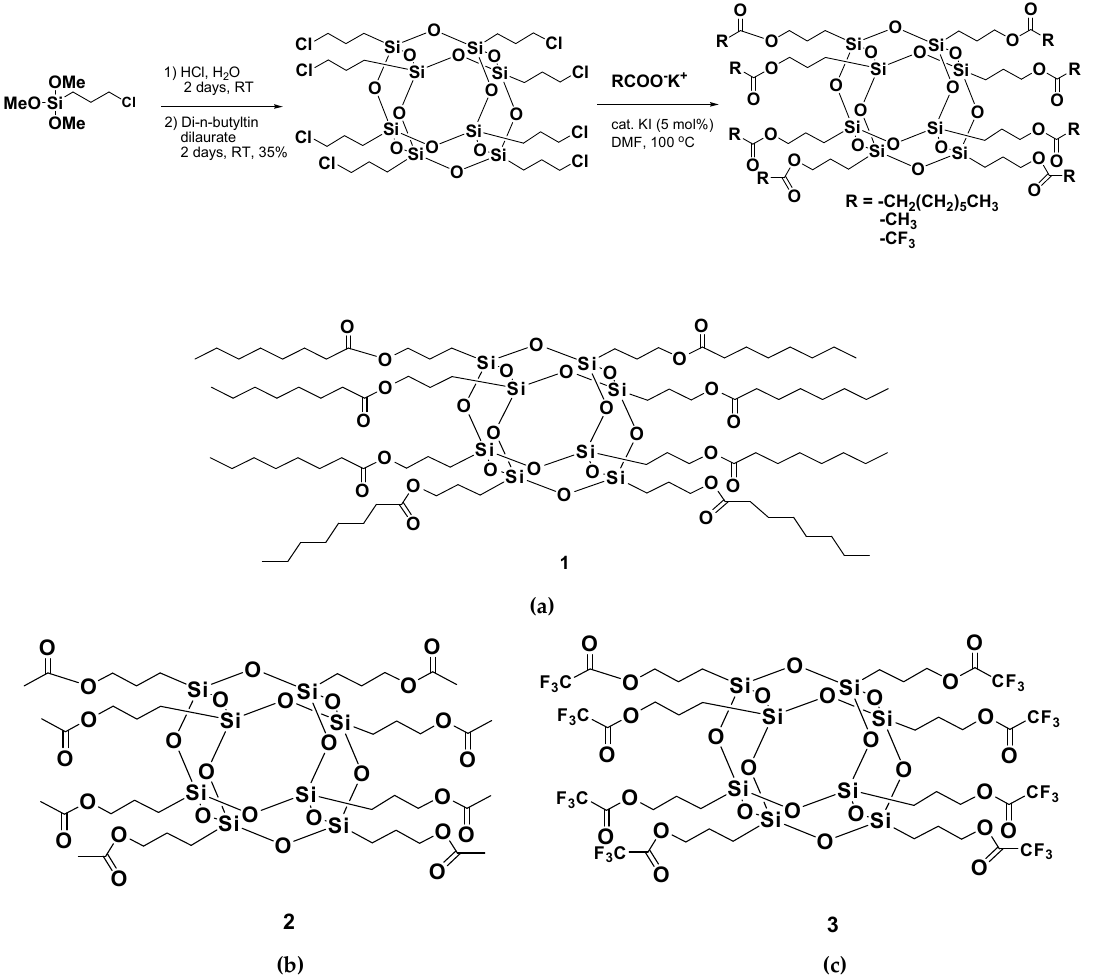
Figure 2. SynthesisofPOSSestercompounds[22,23]: ( a )POSS-C8(1). ( b )POSS-C2(2). ( c )POSS-C1CF 3 ( 3 Figure 2. Synthesis of POSS ester compounds [22,23]: (a) POSS-C8 (1). (b) POSS-C2 (2). (c) POSS- C1CF 3 ( 3 ).